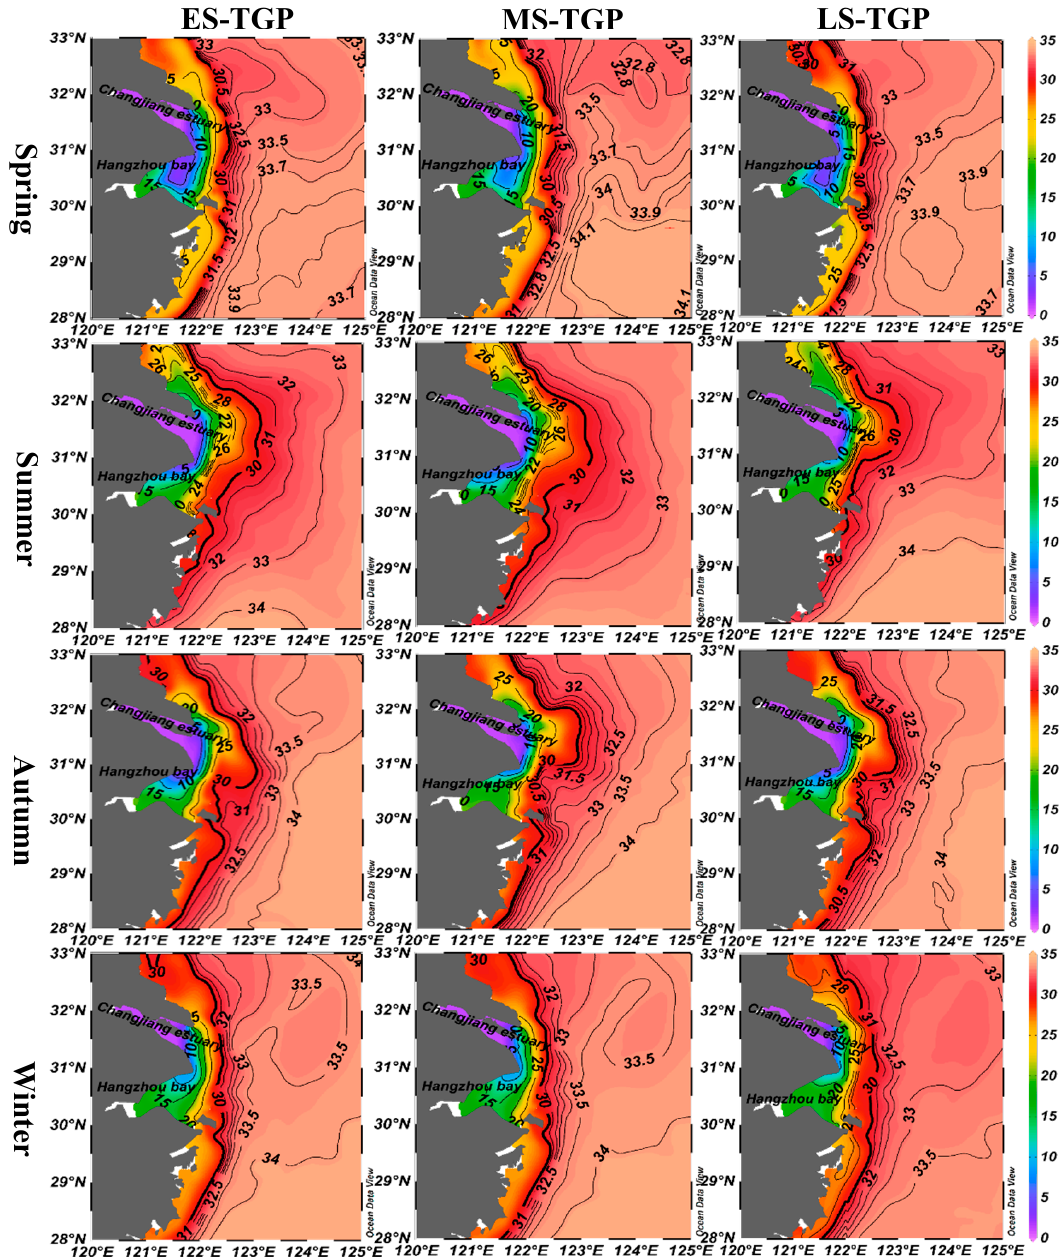
Figure 5. Seasonal average of the modeled horizontal distribution of the surface salinity around the Changjiang Estuary and adjacent ECS during different TGP periods. The bold curve represents a salinity of 30.